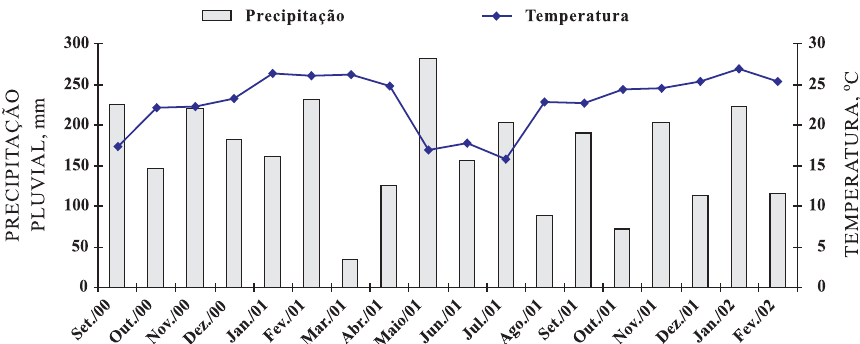
Figura 2. Temperatura média e precipitação pluvial mensal de setembro de 2000 a fevereiro de 2002 no município de Tibagi, Paraná. Fonte: Cooperativa Batavo e Fundação